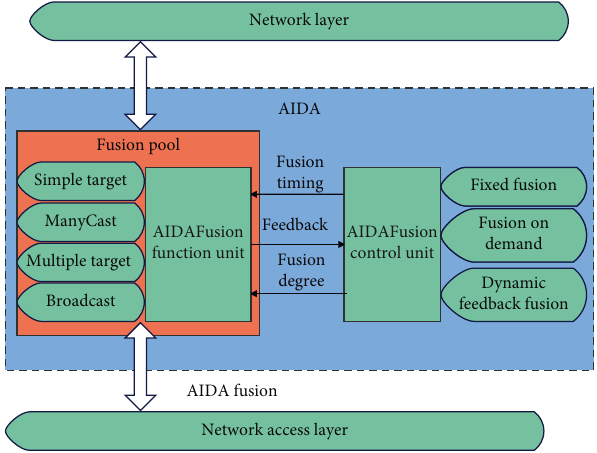
Figure 7: Composition diagram of